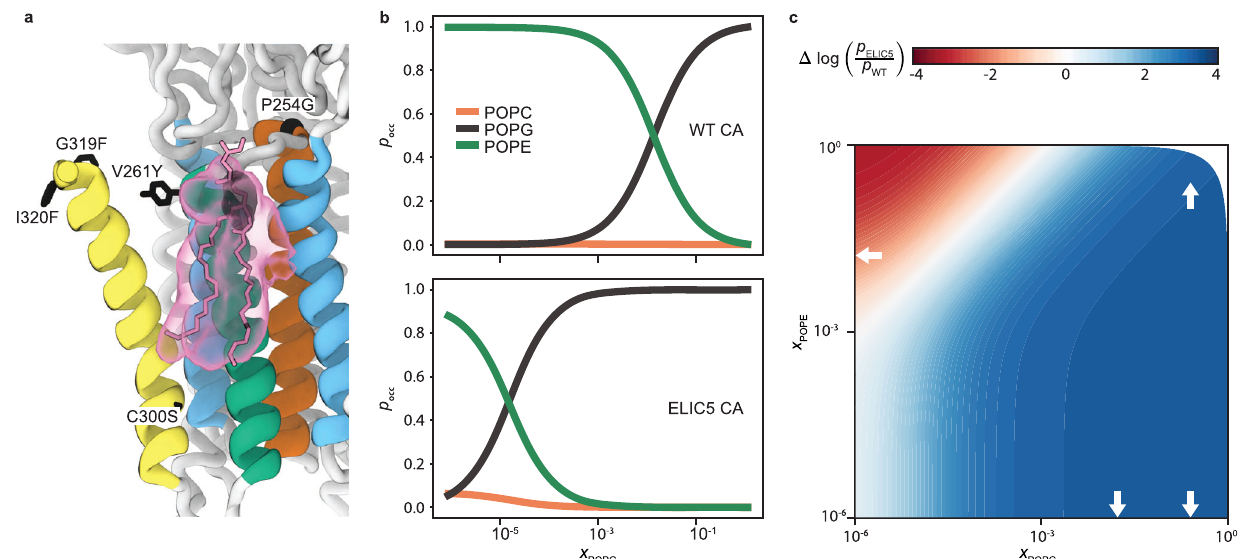
Fig. 5 | Predicted lipid occupancy for the outer lea fl et phospholipid binding site. a ELIC5 CA structure showing lipid density from a brief 20ns equilibrium MD simulation to estimate expected thermal fl uctuations of the glycerol backbone around the structurally-modeled POPG (pink licorice). The region of glycerol backbone density is shown in black, while the remaining lipid density is shown in pink. The fi ve mutations of ELIC5 are shown in black licorice. b The SAFEP- calculatedprobability (p occ )thatthe structurally-identi fi edsite willbeoccupied by each of three possible lipids in a 2 POPC :1 POPE : x POPG mixture, for both the WT CA